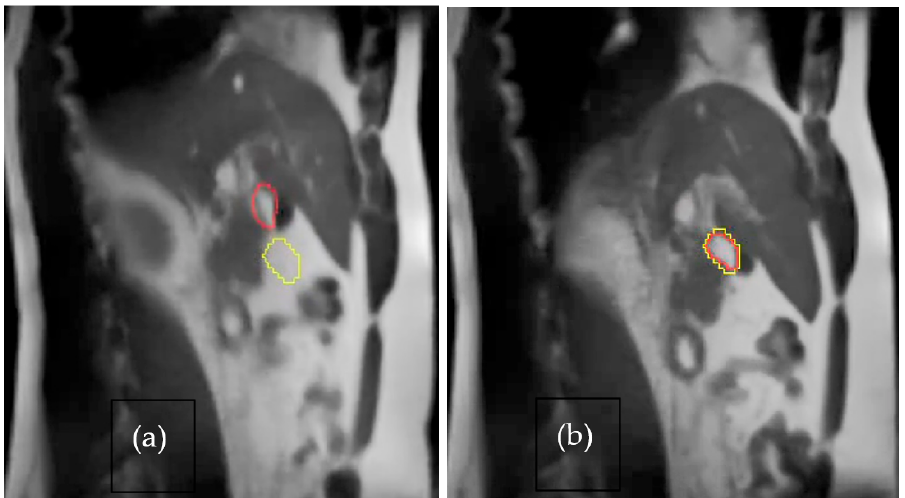
Figure 4. MRI cine image showing motion; ( a ) tracking structure (red) is out of defined boundary (yellow) and ( b ) with breath holding, tracking structure is in the boundary, which is automatically synchronized by the treatment delivery in MR-Linac from ViewRay.